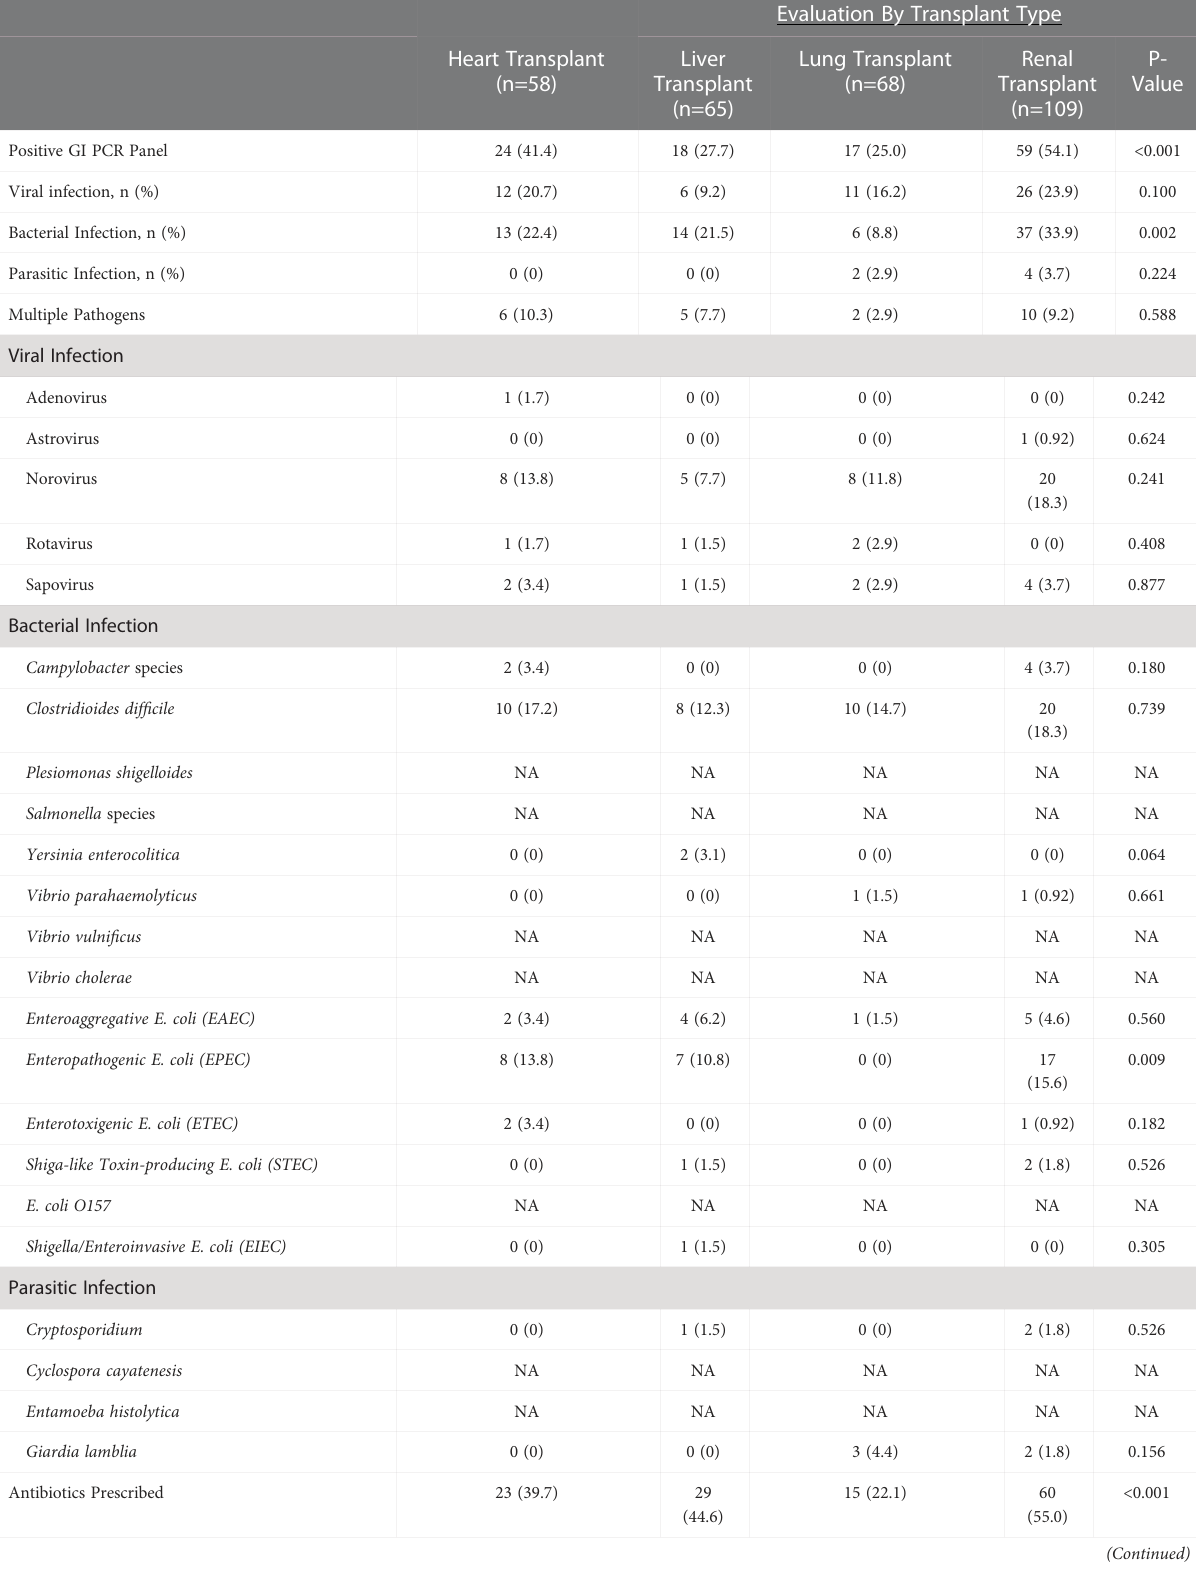
TABLE 2 GI panel results by transplant